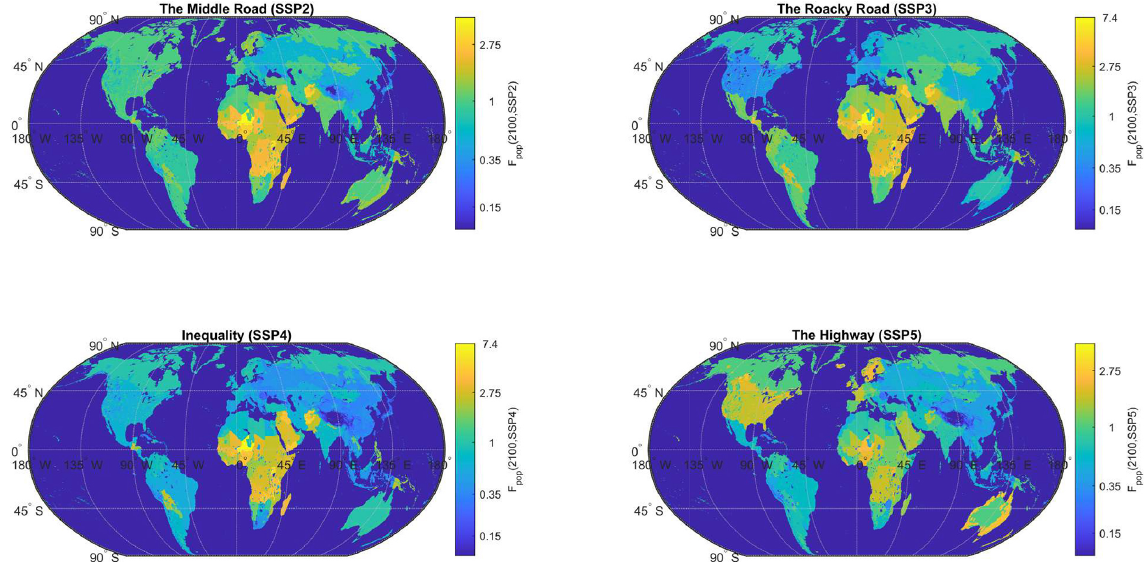
Figure 15. Local F pop factor variation in all SSPs in 2100 (source: Jones and O’Neill, 2020, NASA Socio-Economic Data Application Center – SEDAC). The scenario-based population grid generation methodology is detailed by Jones and O’Neill (2020) with a last version downscaled at 1km following Gao (2020). This population grid is available every 10 years. CATHERINA uses the closest value in the definition of the